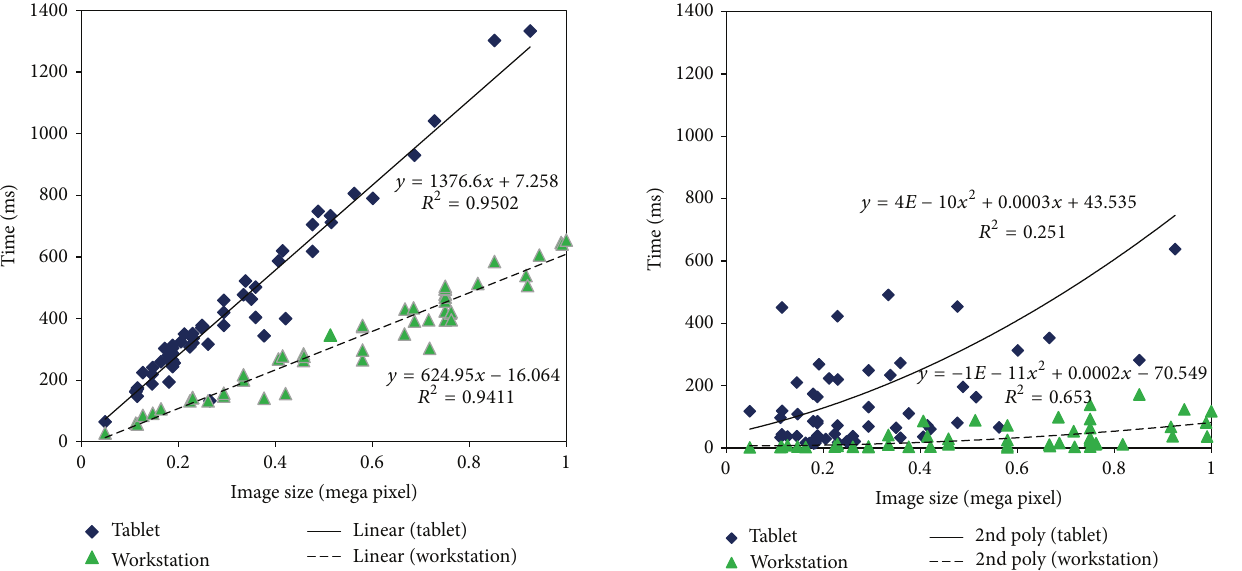
Figure 11: Computational time for contour analysis with different image